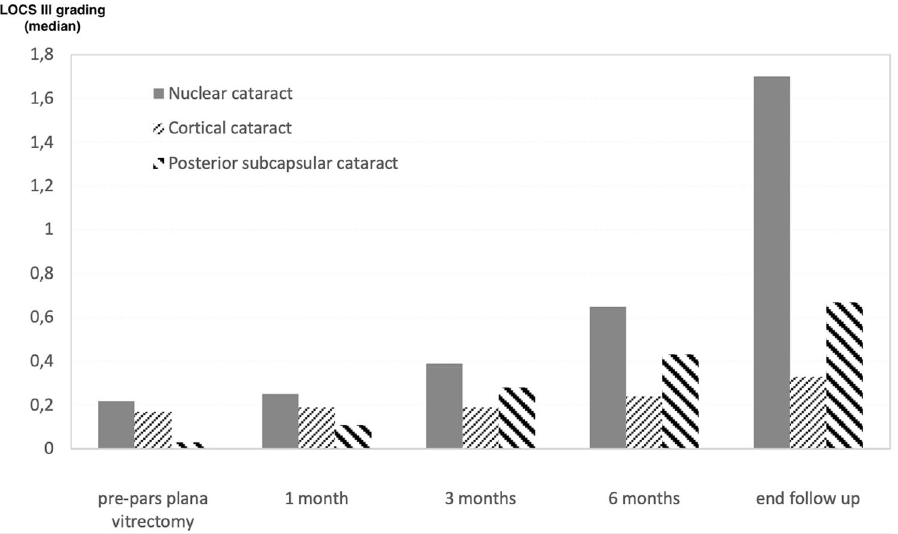
Figure 2. Progression of the various types of cataract according to the LOCS III grading system. The 12-month timepoint was omitted in order not to miss the cases indicated for surgery between the 6-month and the 12-month